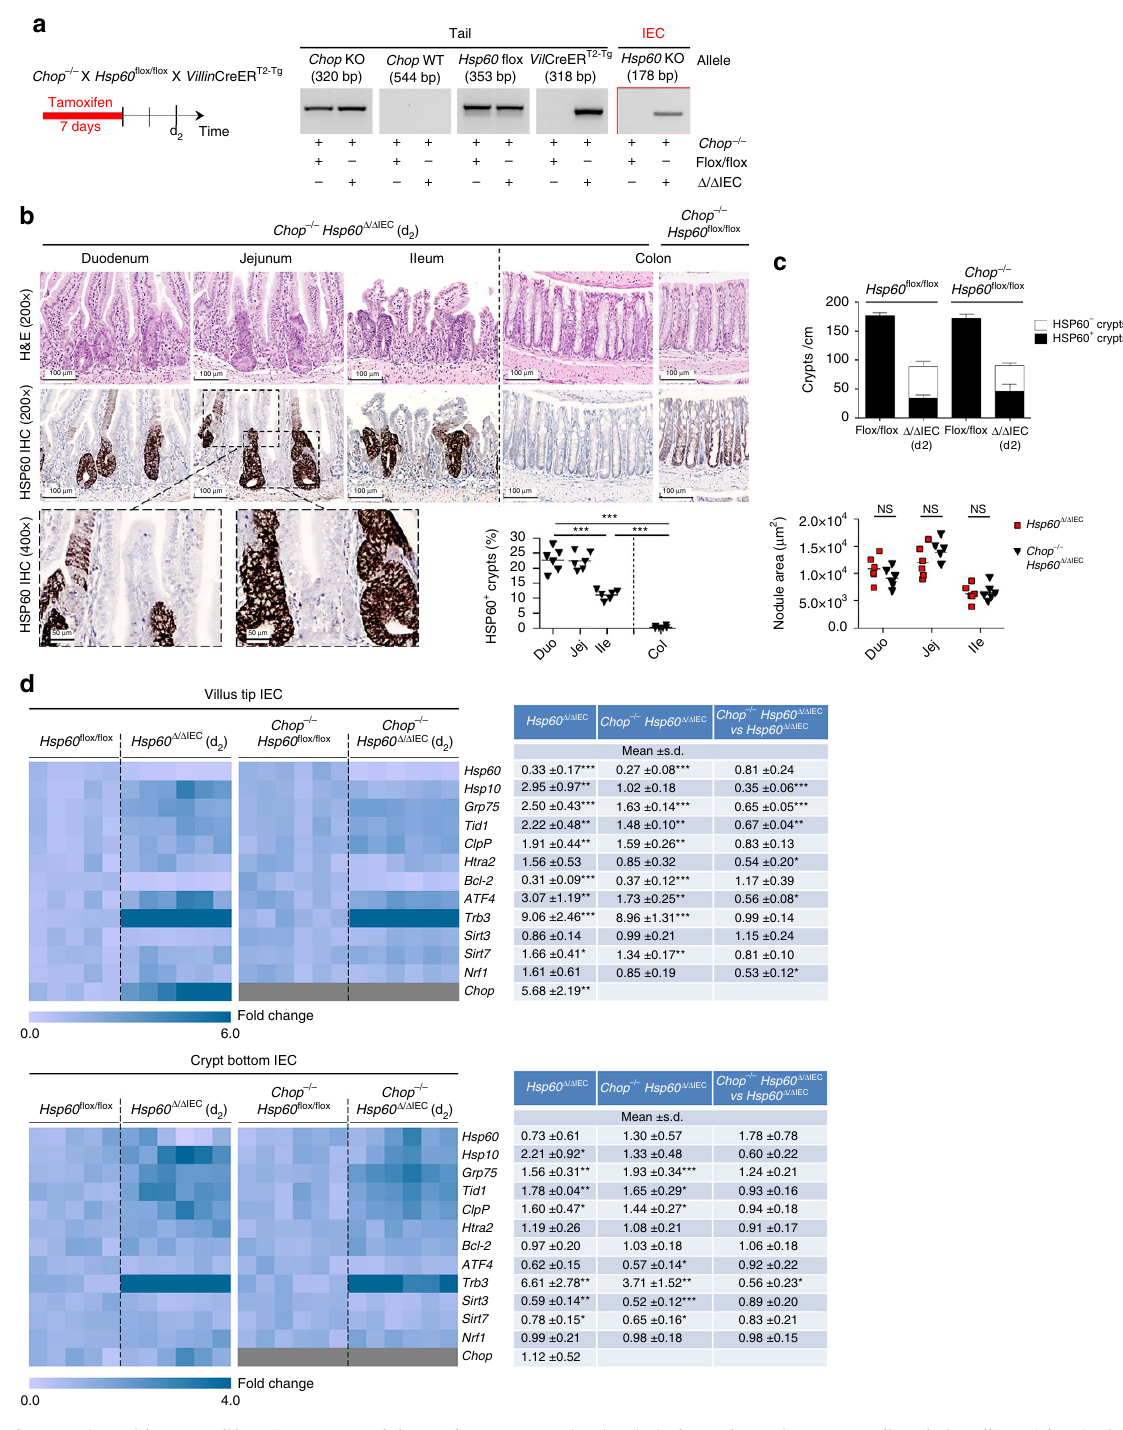
Figure 2 | Formation of hyperproliferative crypt nodules and MT-UPR activation is independent of CHOP-mediated signalling. ( a ) Schedule for oral tamoxifen administration to induce HSP60 deficiency in IEC of adult Chop (cid:2) / (cid:2) Hsp60 D / D IEC mice. Agarose gels showing the presence of the knockout allele specifically in IEC isolates. ( b ) Representative H&E and corresponding HSP60 IHC stainings of Chop (cid:2) / (cid:2) Hsp60 D / D IEC mice along the intestinal tract. Images of HSP60 IHC in higher magnification show HSP60-deficient villus versus HSP60-positive crypt regions of the jejunum. HSP60-positive crypt nodules in Chop (cid:2) / (cid:2) Hsp60 D / D IEC mice were counted along the intestinal tract using HSP60 IHC stainings. The graph represents quantifications of Hsp60 D / D IEC mice ( N ¼ 6) with 4 100 crypts counted per animal. Lines indicate mean numbers. One-way analysis of variance (ANOVA) followed by Dunn’s test was used to test for significance. ( c ) Quantification of HSP60-positive and HSP60-negative crypt numbers and total area of HSP60-positive crypt nodules of Hsp60 D / D IEC and Chop (cid:2) / (cid:2) Hsp60 D / D IEC mice revealed no differences between genotypes ( N ¼ 6); unpaired t -tests. Bars represent means þ s.e.m. Lines in the dot plot indicate mean numbers. ( d ) qRT–PCR analysis of MT-UPR-associated genes in villus (upper panel) and crypt (low panel) IEC isolated from Hsp60 D / D IEC ( N ¼ 6) and Chop (cid:2) / (cid:2) Hsp60 D / D IEC mice ( N ¼ 6) and corresponding controls ( N ¼ 5 and N ¼ 6). Statistical analysis was performed using unpaired t -tests. Asterisks indicate significant differences * P o 0.05, ** P o 0.01, *** P o 0.001; NS, not